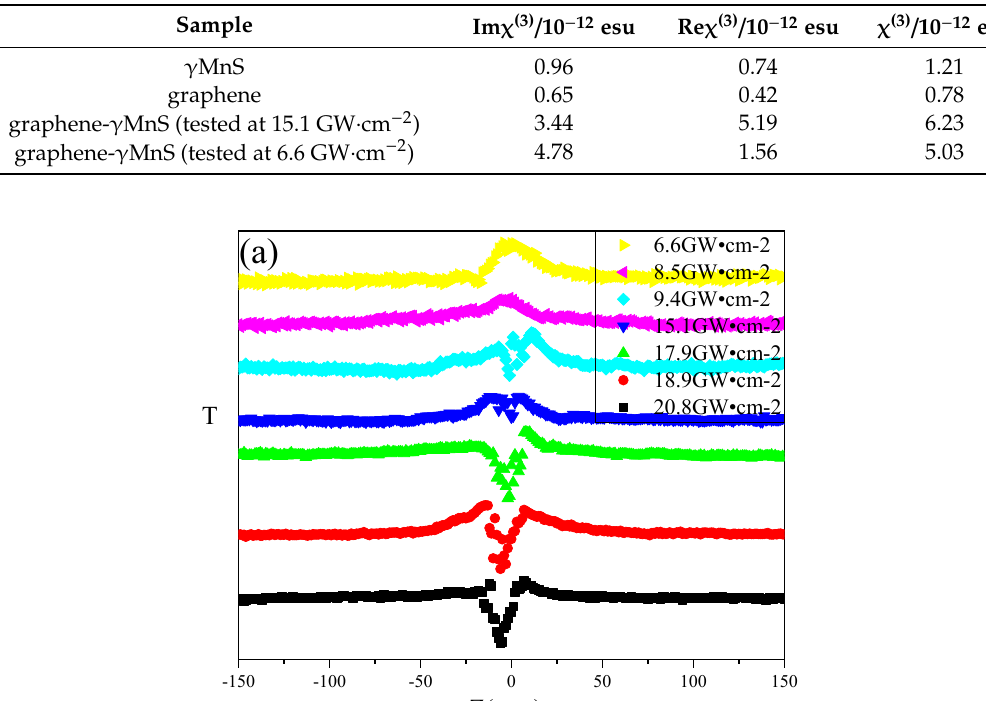
Table 1. The nonlinear optical parameters of γ MnS, graphene and graphene- γ MnS.